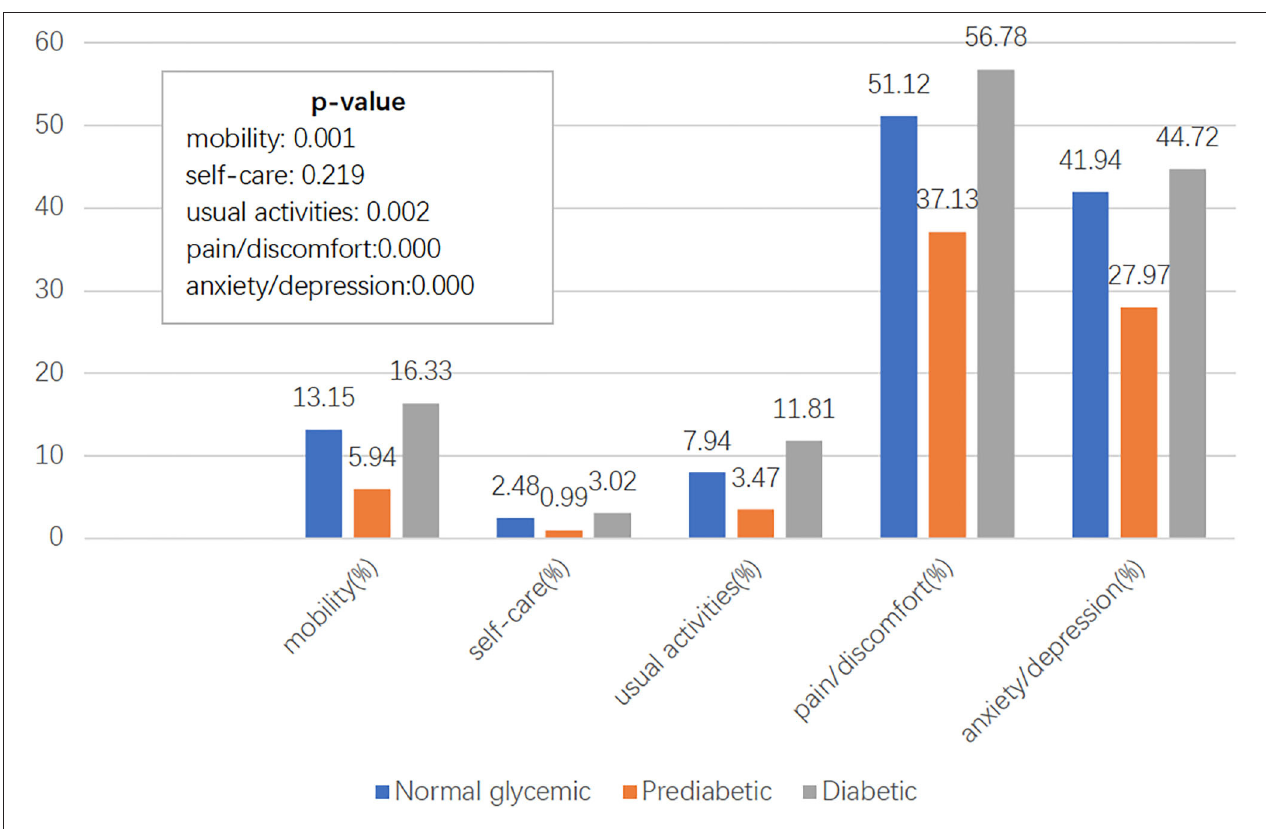
FIGURE 2 | Percentage of self-rated problematic on five